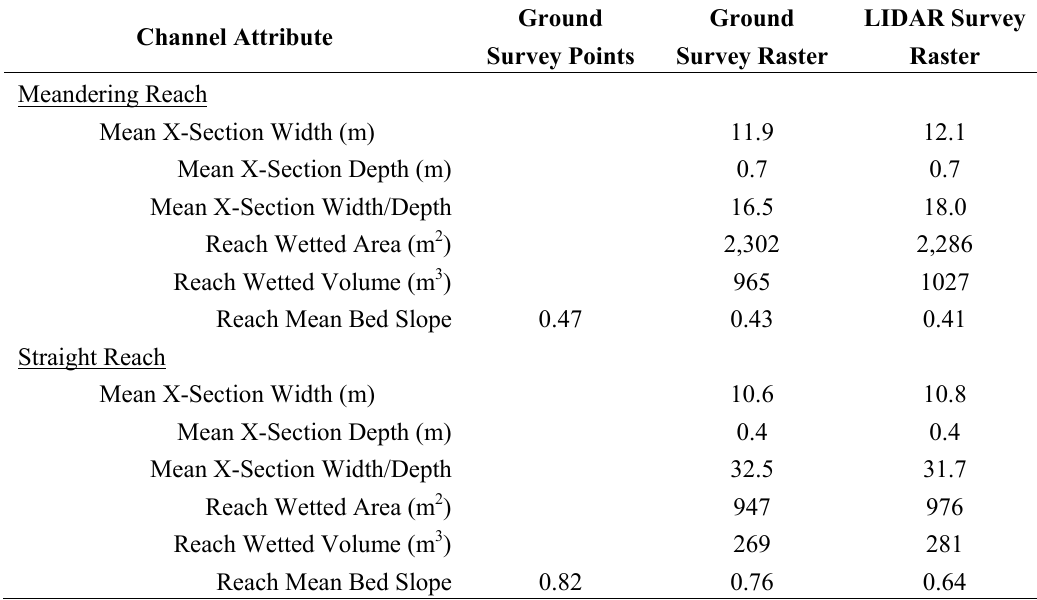
Table 2. Channel geometry comparison by survey methods for a meandering reach with pool-riffle morphology and a straight reach with plane bed morphology. Wetted geometries were calculated below arbitrary water surface elevations. Ground Ground Channel Attribute Survey Points Survey